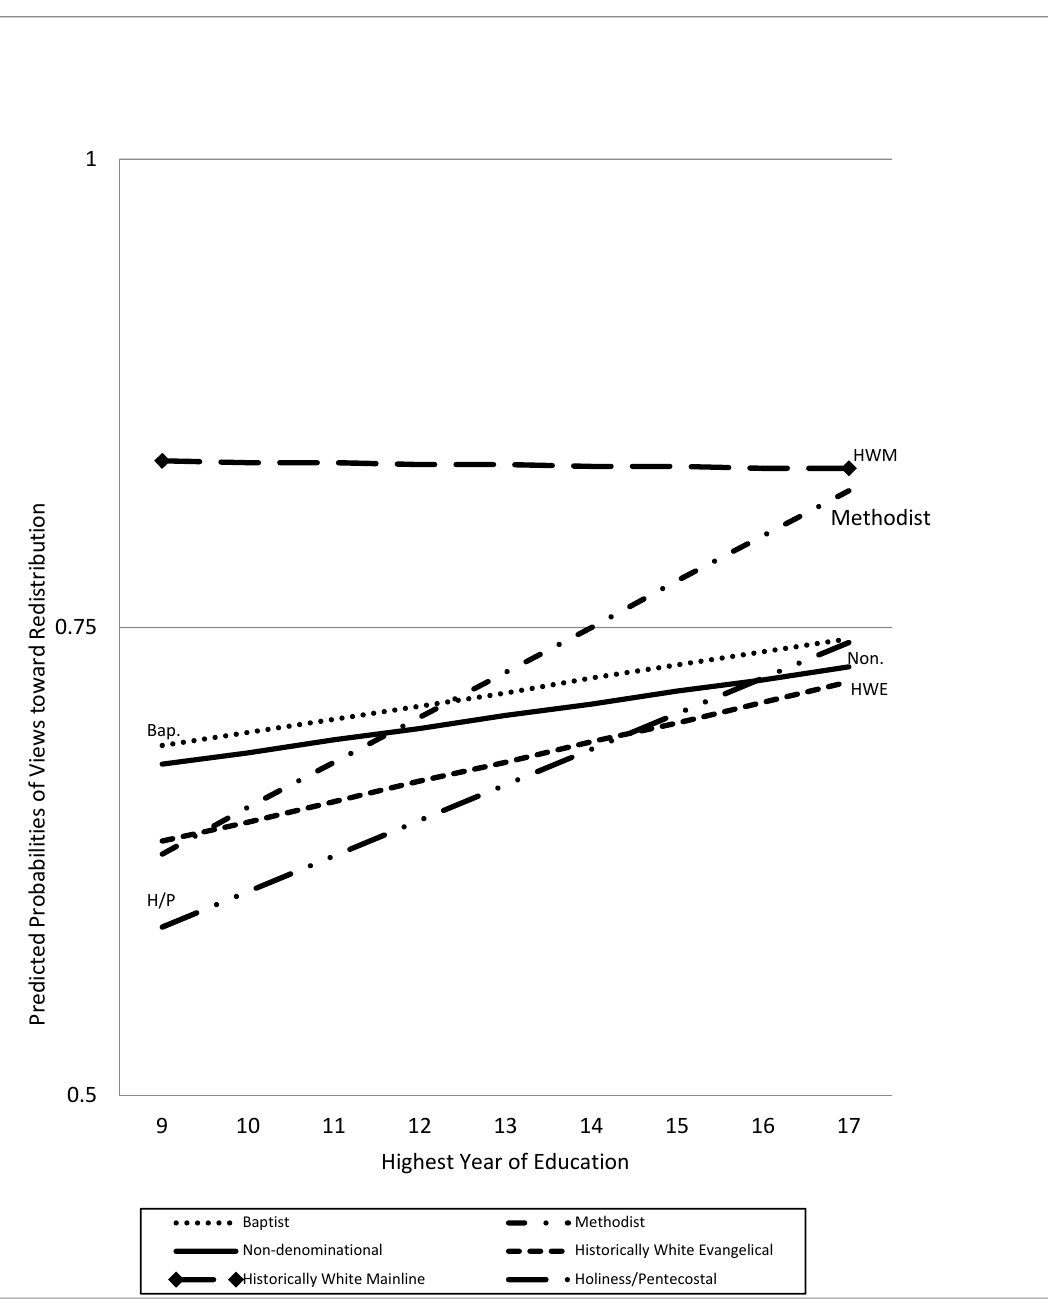
Figure 11. The interaction of education and religion for Black Protestant views on redistribution.